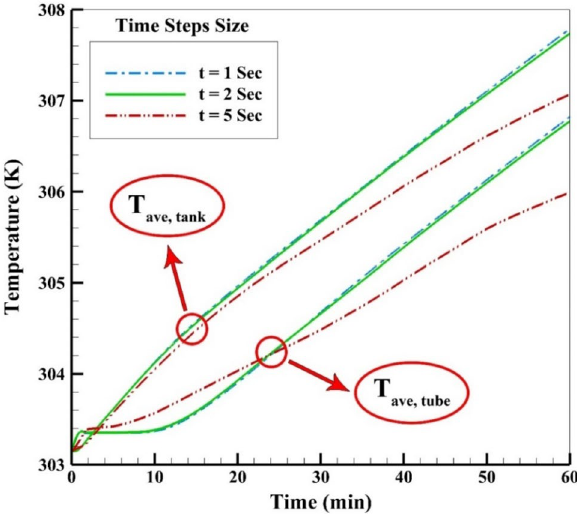
Figure 4. Time step size selection according to the average temperatures.